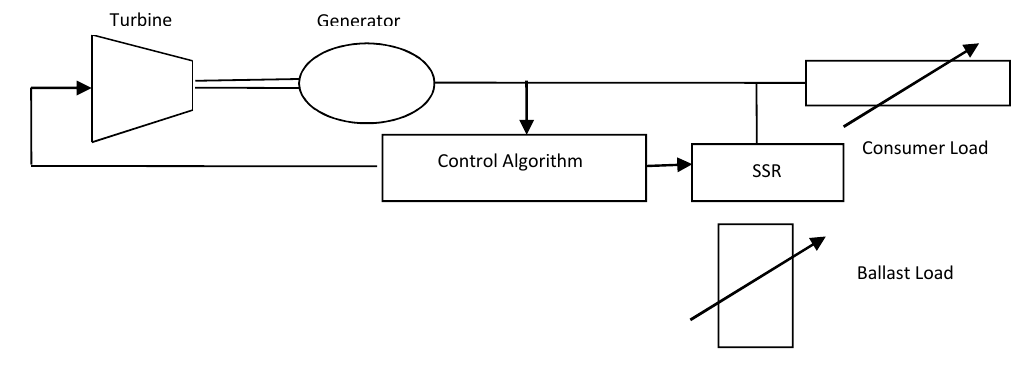
Fig. 4: Schematic Hybrid Control Diagram of Mini Hydro Power